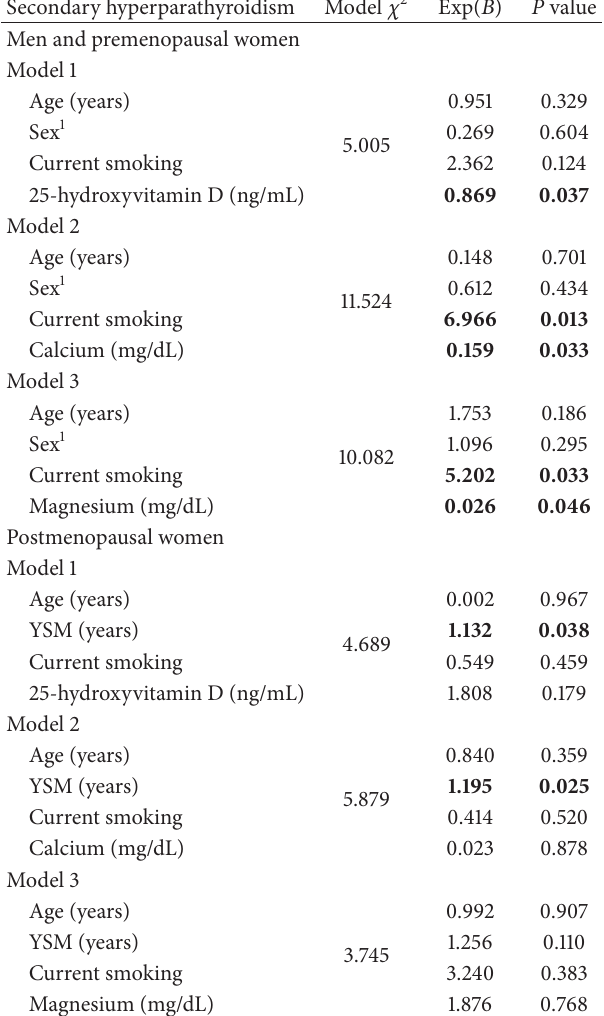
Table 3: Stepwise multivariate logistic regression analysis with the presence of secondary hyperparathyroidism as dependent variable and potential risk factors as independent